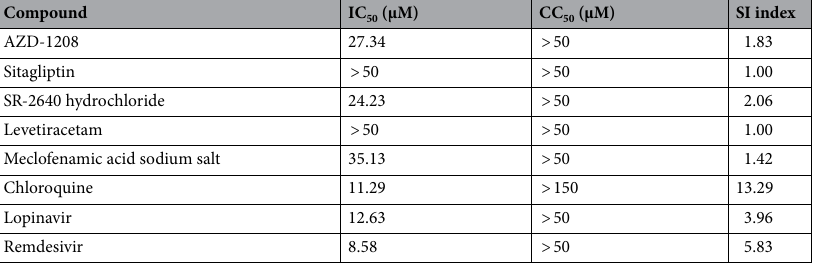
Table 2. Average reversal score predicted anti-SARS-CoV-2 compounds in vitro efficacy testing. IC 50 , CC 50 , and SI index were calculated of each compound in SARS-CoV-2 infected in Vero cells. . No compound exhibited reasonable anti-SARS-CoV-2 activities due to high IC 50 across board.